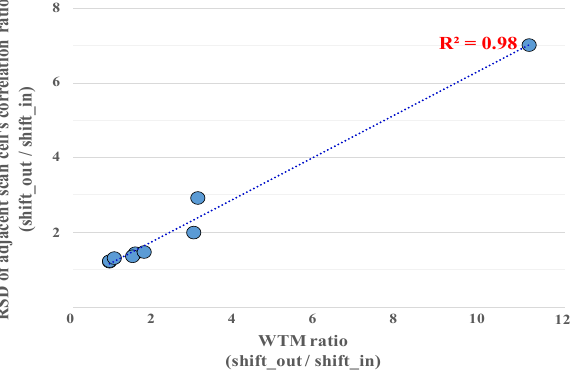
Figure 6. WTM and relative standard deviation (RSD) of adjacent scan correlation. Consider the example of reducing the shift-out transitions using the proposed method. The shift-in transitions are not considered in this example, to simplify the explanation. First, a response vector is prepared by performing scan chain stitching with the conventional method, where scan chains are stitched alphabetically, and by running the ATPG with a 0-fill. Figure 7a illustrates the example response vector, which has seven scan cells and ten vectors.